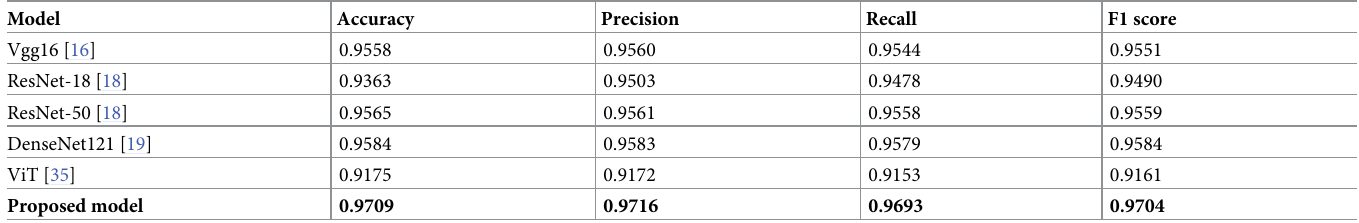
Table 3. Performance comparison of the proposed model with some DL-based models on the present dataset.